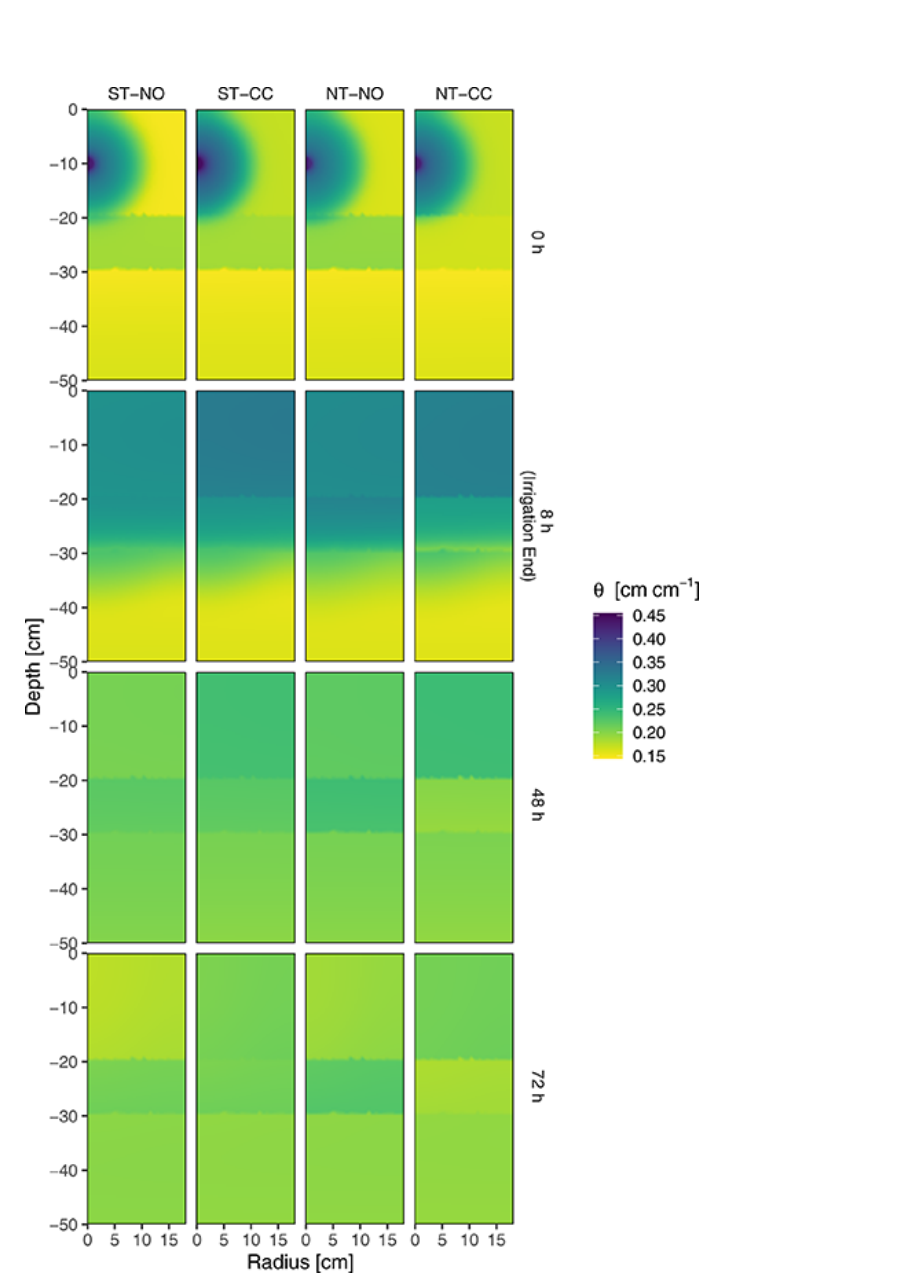
Figure A4. Soil water content distribution in the model domain at selected times during and after irrigation (treatment means).